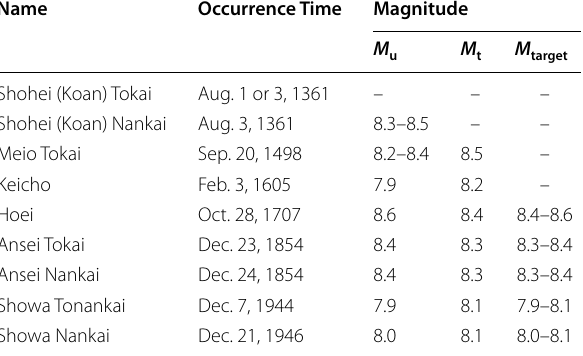
Table 1 Occurrence times and magnitudes ( M magnitude; M , tsunami magnitude) of historical great t earthquakes along the Nankai Trough (Earthquake Research Committee 2013) and our target magnitude range ( M each of those